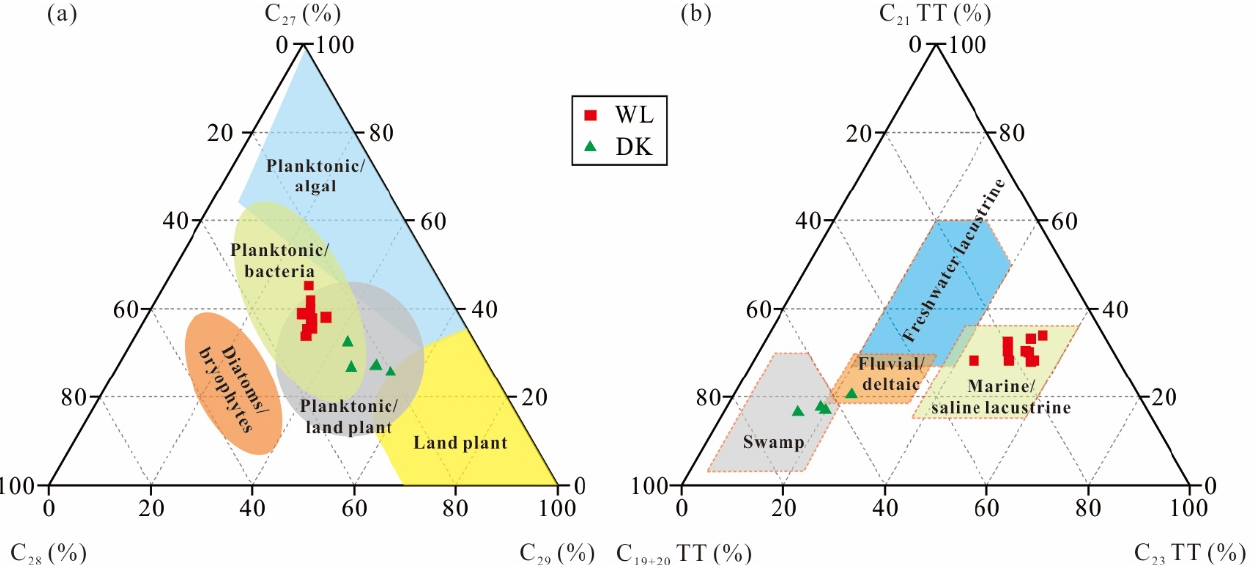
Figure 10. Ternary diagrams showing the relative distribution of ( a ) C 27 -C 28 -C 29 -sterane [86] and ( b ) C 19+20 -C 21 -C 23 -tricyclic terpane [89].